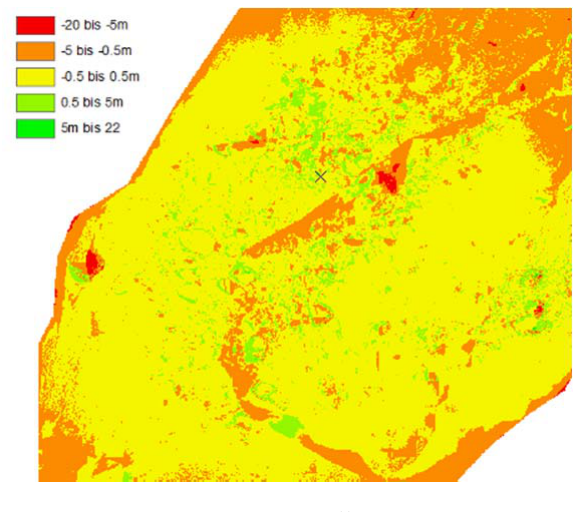
Figure 11: DSM Differences